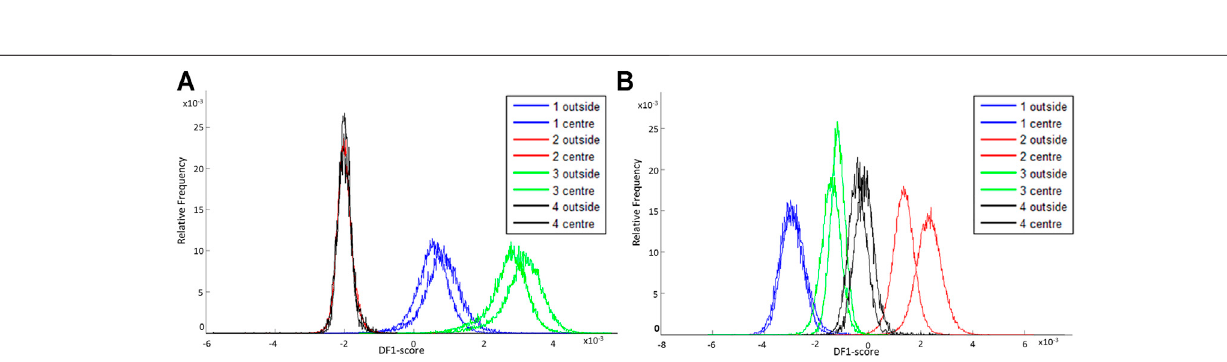
Frontiers in Chemistry |